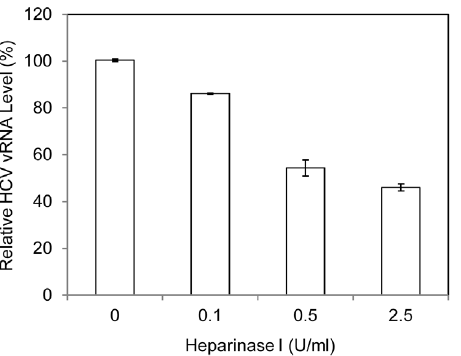
Figure 3. Effect of heparinase treatment on HCV1b attachment to DHHs. The day-11 DHHs in 12-well cell culture plates were incubated with varying concentrations of heparinase I in a buffer containing 20 mM Tris-HCl (pH 6.8), 50 mM NaCl, 4 mM CaCl 2 and 0.01% bovine serum albumin at 37 u C for 1 hr [18]. The heparinase- treated DHHs were then incubated with HCV1b on ice for 2 hrs. The unbound HCV was removed and the cells were washed with 1x PBS for three times. The HCV1b vRNA of the cell-bound HCV was extracted with Trizol reagent and quantified by RT-qPCR using the StepOnePlus real- time PCR system same as that in Fig. 1.